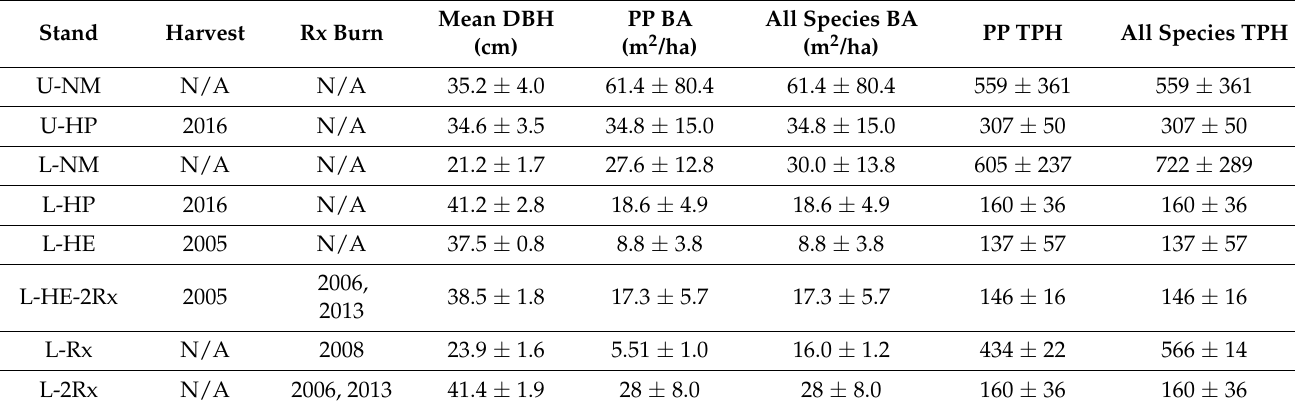
Table 1. Description of stands in the study area where trees were sampled. Key to stand codes: L = lowland, U = upland, HE = harvest, even spacing, HP = harvest, patchy (clumps and openings), Rx = prescribed fire, NM = no management, no harvest or fire. Diameter at breast height (1.37 m above ground, DBH), BA (basal area), and trees per hectare (TPH) data from [32]. These data are based on the DBH and species of each tree in three 30 m radius plots in each site. Values are the mean ± SD. PP = ponderosa pine. N/A indicates that no belt transects were conducted in these stands. Stand